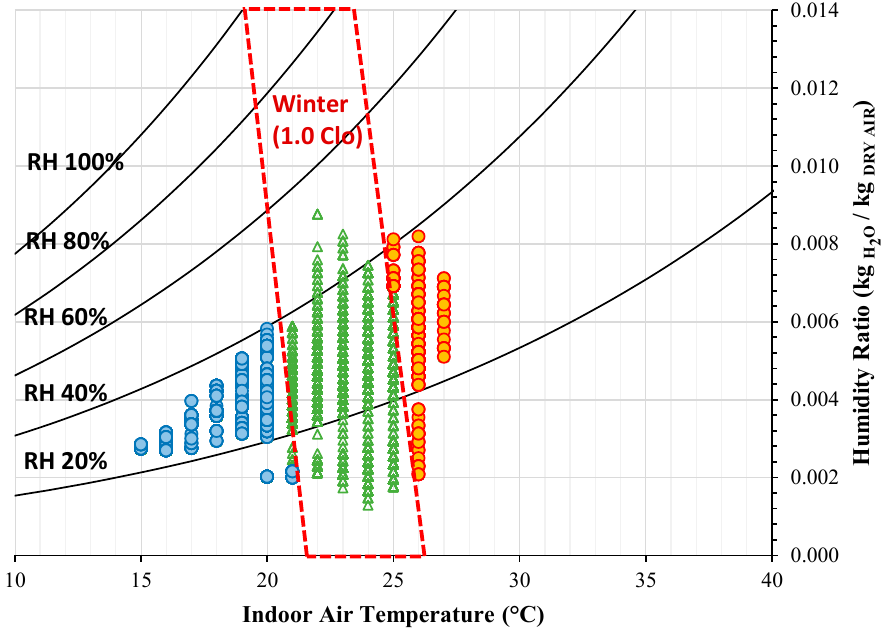
Figure 5. Graphical comfort zone analysis. RH, relative humidity.